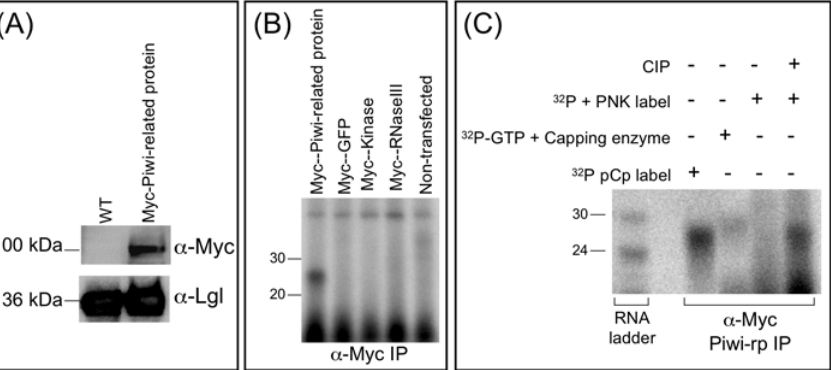
Figure 4. 27 nt polyphosphate small RNAs associate with E.histolytica Piwi-related protein. (A) Western blot analysis of Myc-EhPiwi-rp. Using an anti-Myc antibody, signal is detected at , 100 kD in the Myc-EhPiwi-rp transfectants. No signal is detected in the extract made from untransfected cells. An antibody to the light subunit of the E. histolytica surface lectin (Lgl) was used as a loading control. (B) Immunoprecipitation was performed with a -Myc antibody on parasites stably transfected with Myc-EhPiwi-rp, Myc-GFP, Myc-EhKinase, Myc-EhRNaseIII, and non- transfected parasites. RNA was extracted, labeled with a -P 32 pCp and resolved on a denaturing gel. A , 27 nt small RNA population was specifically identified as immunoprecipitating in the Myc-EhPiwi-rp cell lines. (C) Small RNAs that IP with EhPiwi-rp can be labeled at the 3 9 end ( a -P 32 pCp), but not at the 5 9 end (PNK), unless first treated with CIP. A capping enzyme labels the immunoprecipitated samples indicating that the EhPiwi-rp associated 27 nt small RNAs have 5 9 di- or triphosphate